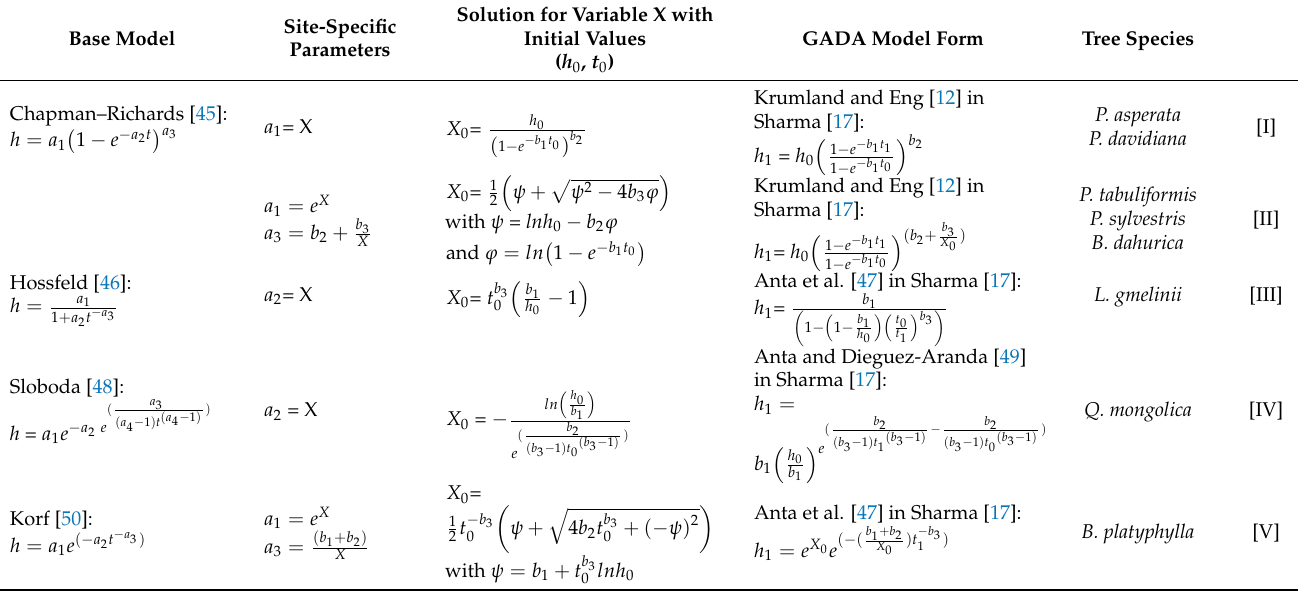
Table 3. Base models and generalized algebraic difference models (GADA) fitted to top height time series. a 1 a 2 , a 3 and a 4 are parameters in the base model; b 1 , b 2 , and b 3 are parameters in the GADA models; h 0 and h 1 are heights (in m) at age t 0 and t 1 (in years); X 0 is the solution for X with initial values of height ( h 0 ) and age ( t 0 ). Detailed derivation of the models are given by Cieszewski and Bailey